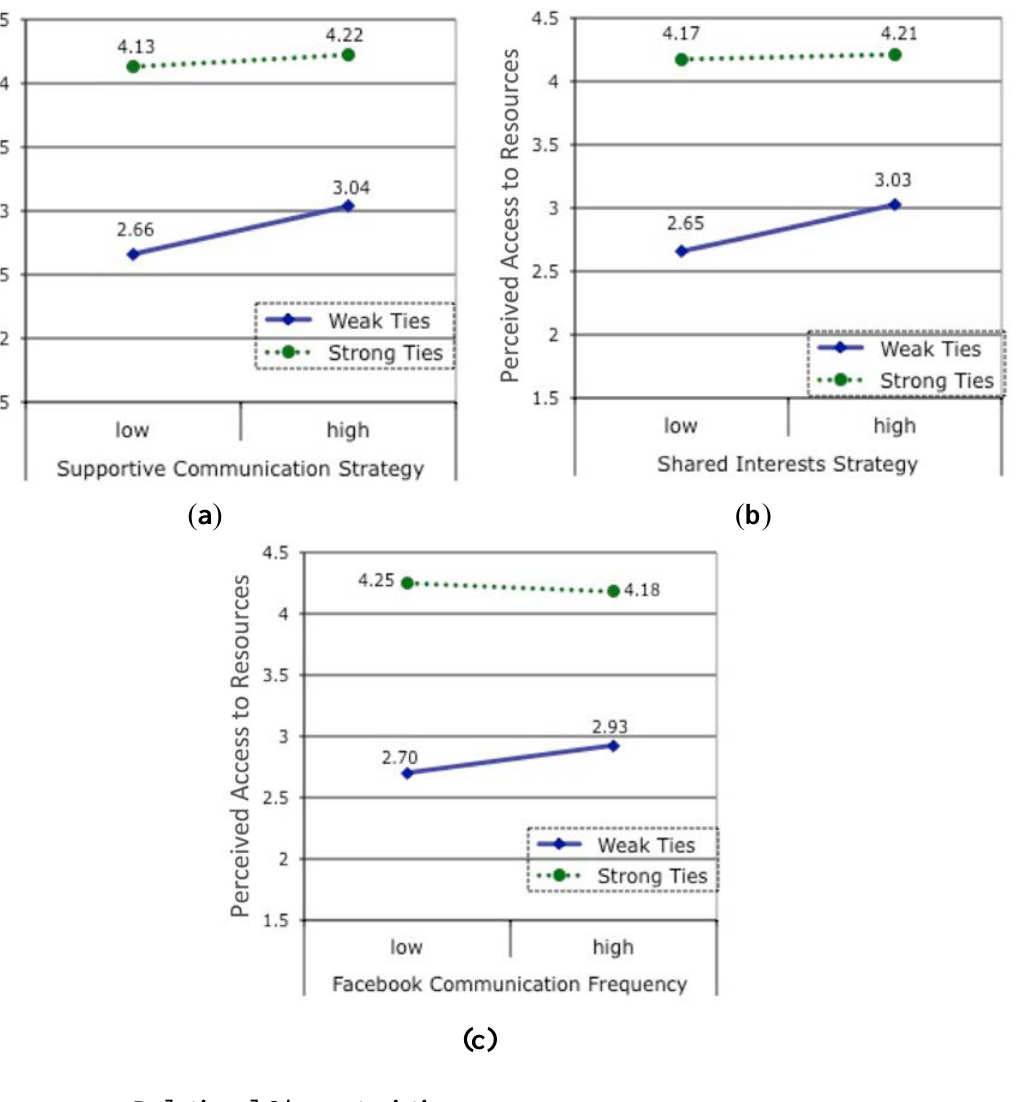
Figure 1. Interaction effects between relational closeness and (a ) supportive communication behaviors; ( b ) shared interests behaviors; and ( c ) Facebook communication frequency in predicting perceived access to resources from a specific Facebook friend. All interactions reveal that among weaker ties, increased engagement in communicative behavior is associated with a g reater increase in perceived access t o resources than is seen among strong